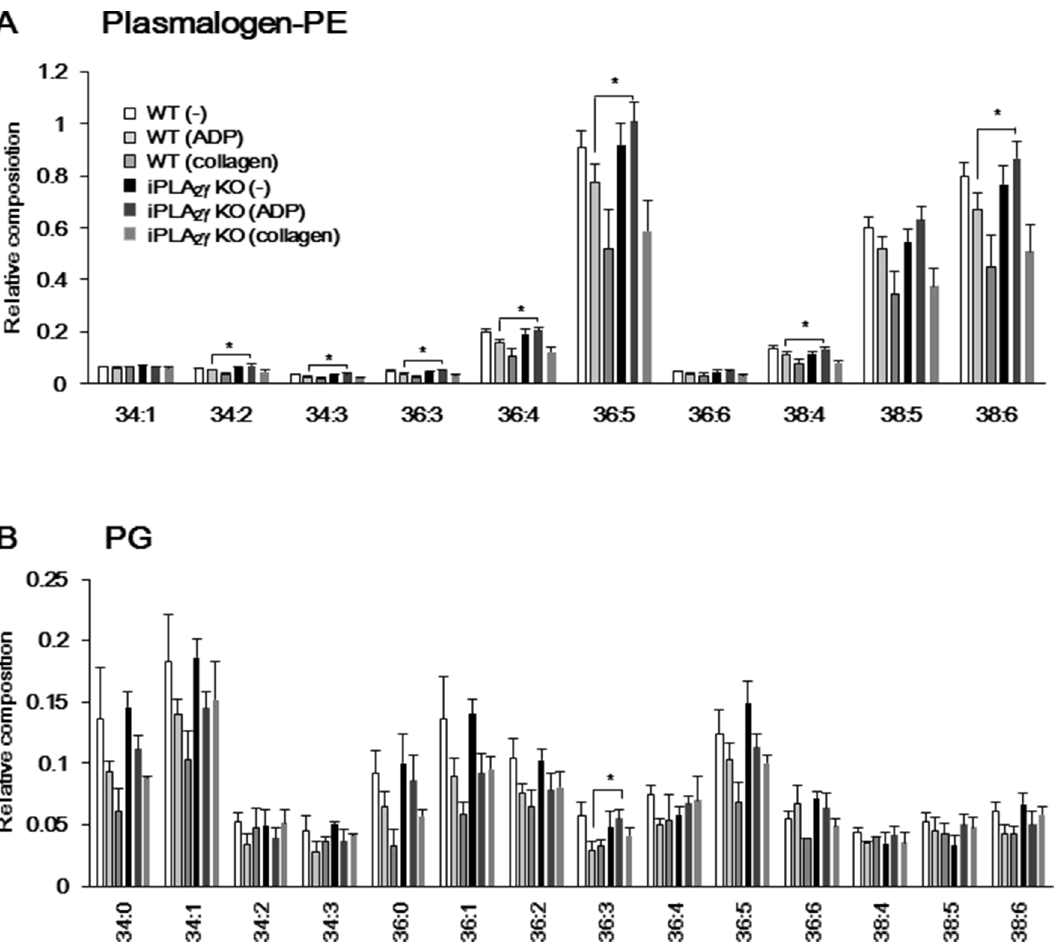
Figure 5. ESI/MS analysis of plasmalogen-PE and PG species in WT and iPLA 2 c -KO mouse platelets. Total lipids were extracted from resting or ADP (10 m M)-stimulated platelet lysates and then subjected to ESI/MS analysis of PG and PE. Levels of (A) plasmalogen-PE and (B) PG in resting state of WT (–) or iPLA 2 c -KO platelets (–), or ADP-stimulated WT (ADP) or iPLA 2 c -KO platelets (ADP), and collagen (1 m g/ml)-stimulated WT (collagen) or iPLA 2 c -KO platelets (collagen) (n=7). Results are given as mean 6 SEM. * P , 0.05 between iPLA 2 c -KO and WT.